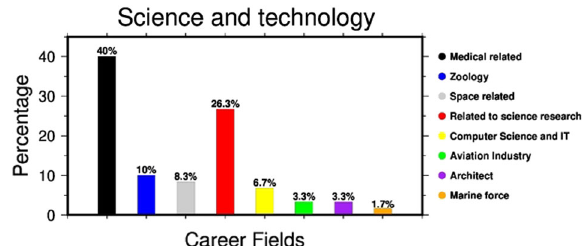
Fig. 1 Desired future career – science and technology. Breakdown of science and technology fi elds selected by the students (according to percentage).